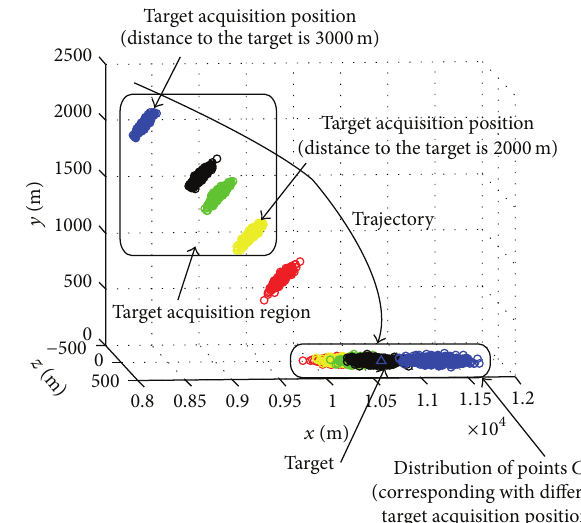
Figure 17: Target acquisition